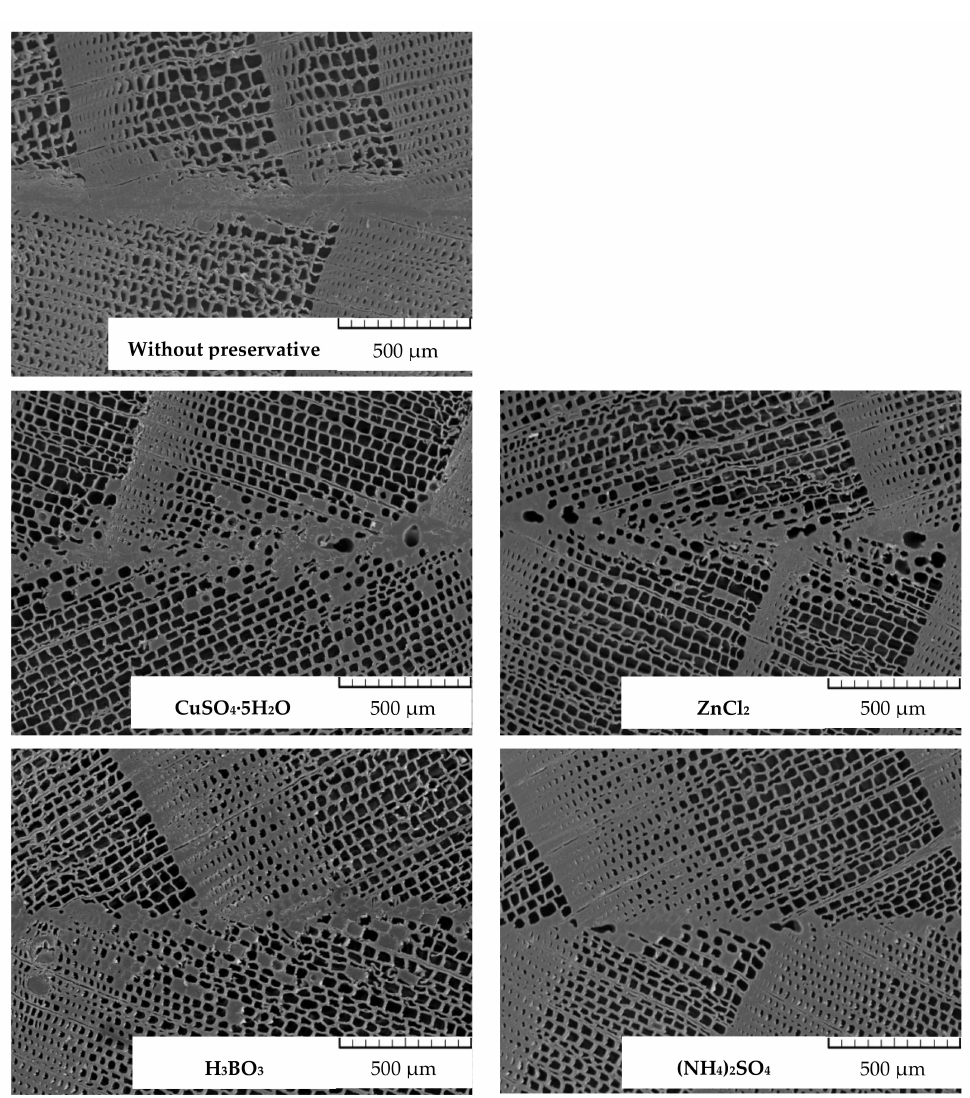
Figure 5. Microscopic analyzes of the “spruce wood—PUR glue” phase interfaces—without or with presence of inorganic preservative in the wood